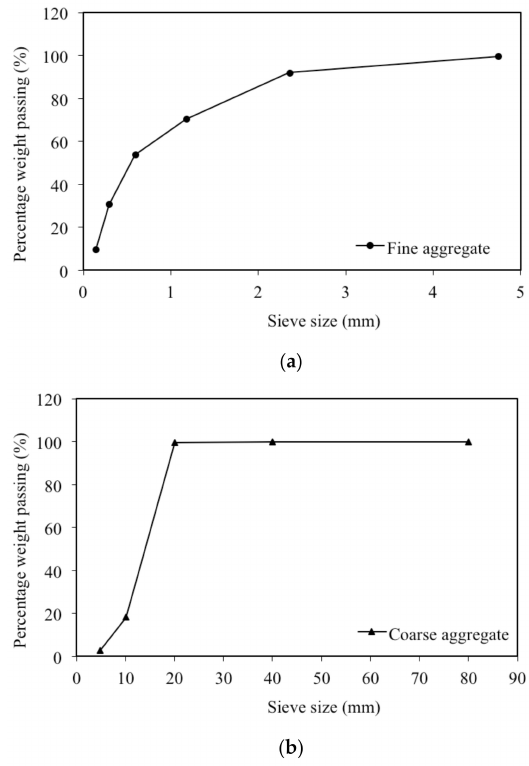
Figure 2. Particle size distribution of: ( a ) Fine aggregate; ( b ) Coarse